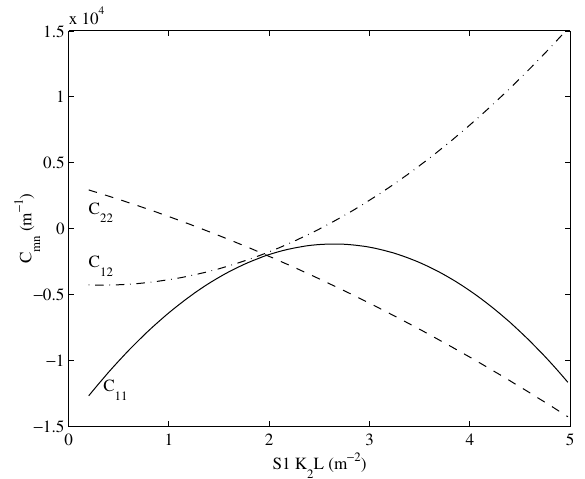
FIG. 1. C ized strength at 2.0